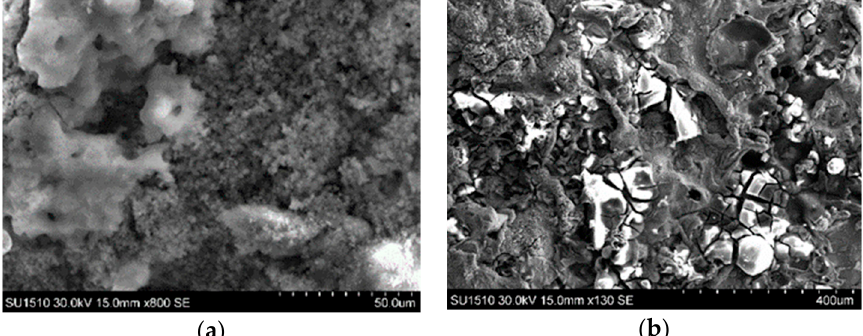
Figure 10. Surface coating of aluminum–bronze after the impedance test for the coating, 69 kPa C 2 H 6 – 345 kPa O 2 . ( a ) Salt crystals, and ( b ) corrosion products.